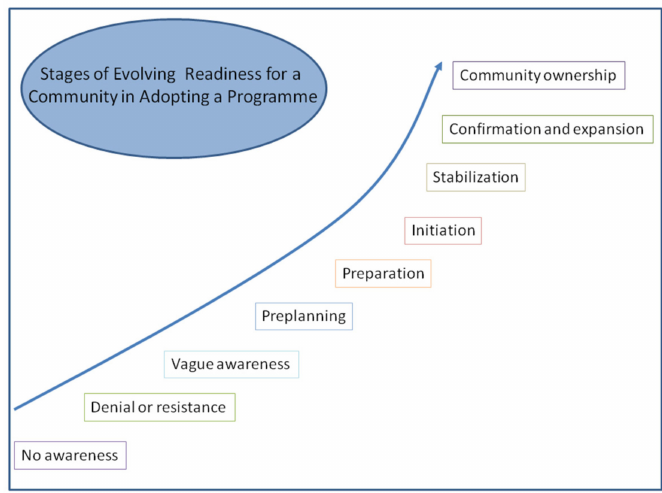
Figure 1. Community readiness model from the Tri-Ethnic Centre for Prevention Research in the University of Colorado